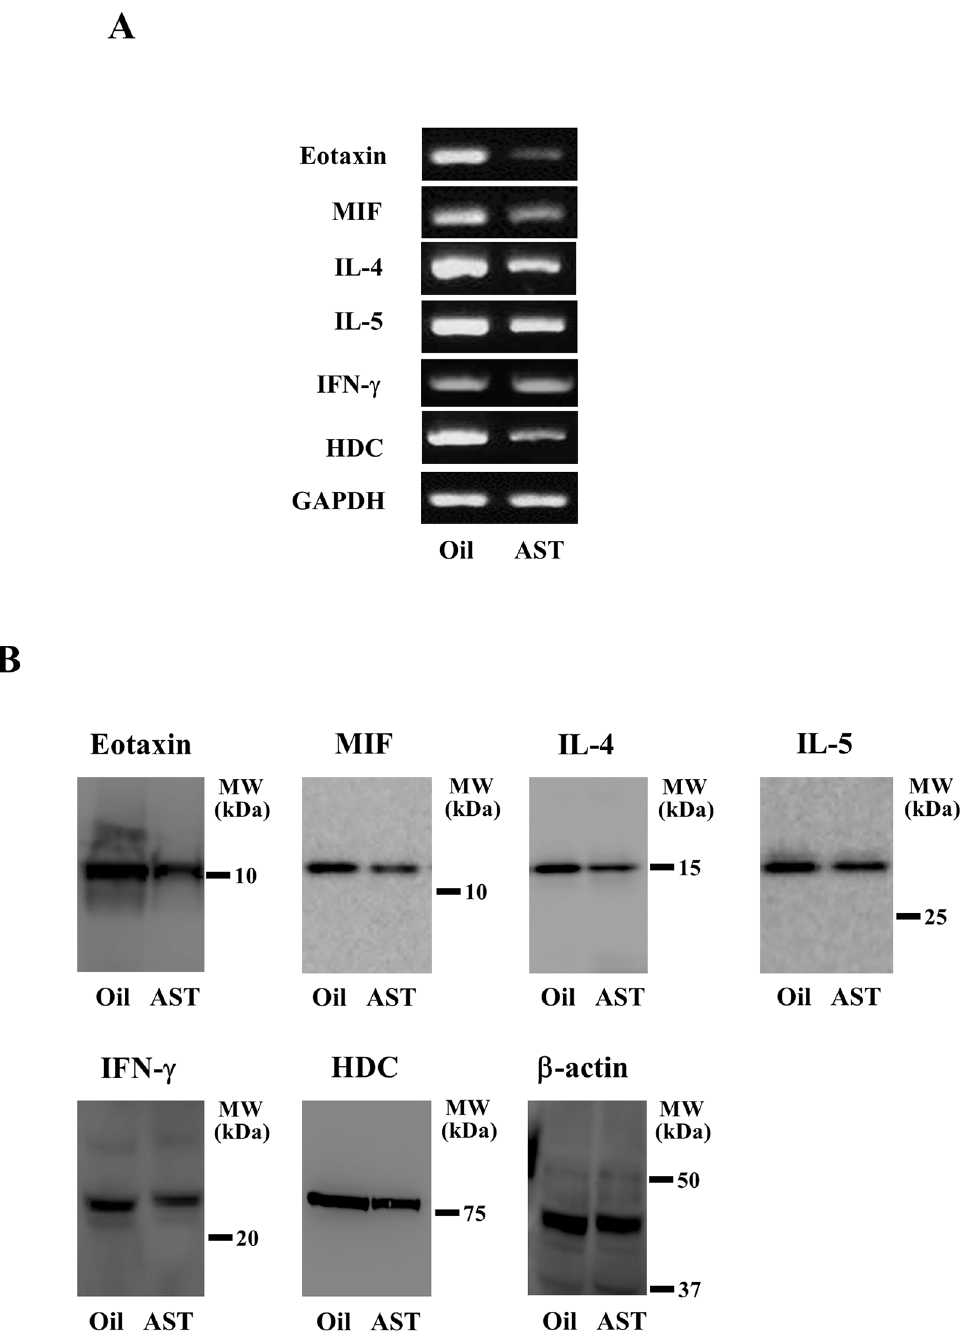
Fig 3. The effects of AST on the expression of pro-inflammatory mediators in the NC/Nga mouse skin. (A) The total RNA was isolated, and the mRNA levels of eotaxin, MIF, IL-4, IL-5, IFN- γ and HDC were detected by RT-PCR. Mouse GAPDH was used as an internal control for the RT-PCR. The data shown are representative of three independent experiments. (B) Skin lysates were prepared, and the protein levels were analyzed by a Western blot analysis using an anti-eotaxin, MIF, IL-4, IL-5, IFN- γ , HDC or anti- β -actin antibody. The anti- β -actin antibody was used as an internal control for the Western blot analysis. Cropped blots are shown, and all of the gels were run under the same